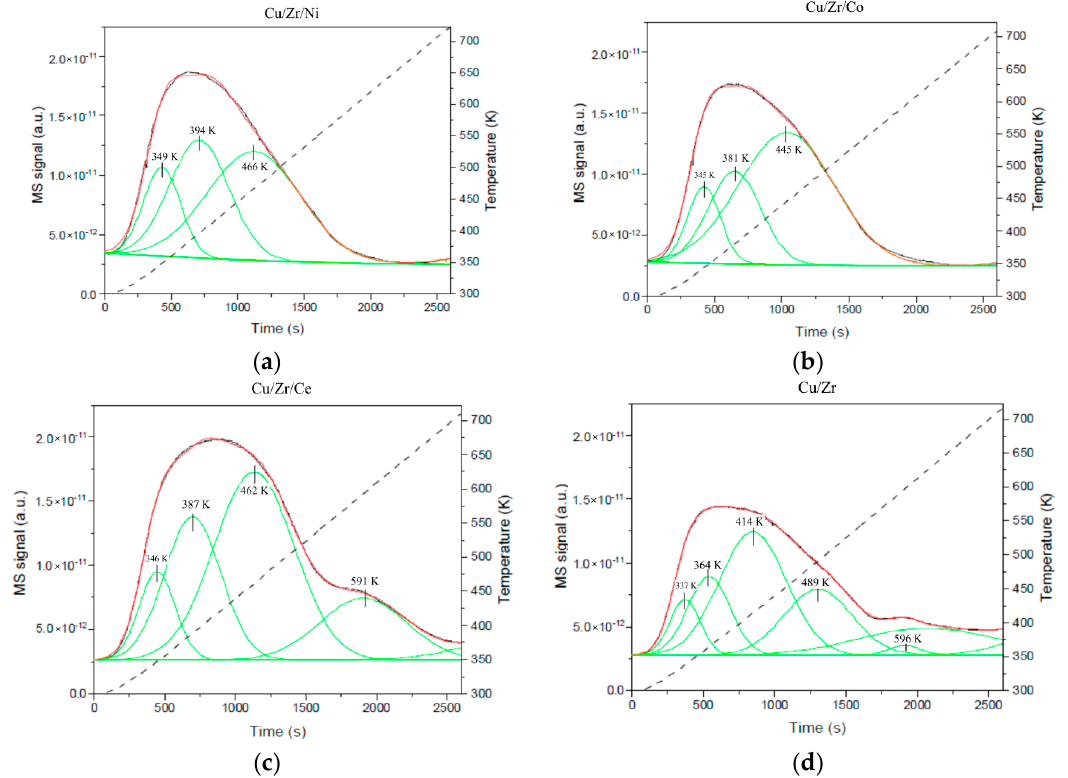
Figure 4. CO 2 temperature-programmed desorption(CO 2 -TPD) profiles for ( a ) Cu/Zr/N, ( b ) Cu/Zr/Co, ( c ) Cu/Zr/Ce and ( d ) Cu/Zr: signal—black line, cumulative curve—red line, deconvoluted peaks used for quantification—green line, temperature—dashed line. (For interpretation of the references to color in this figure legend, the reader is referred to the Web version of this